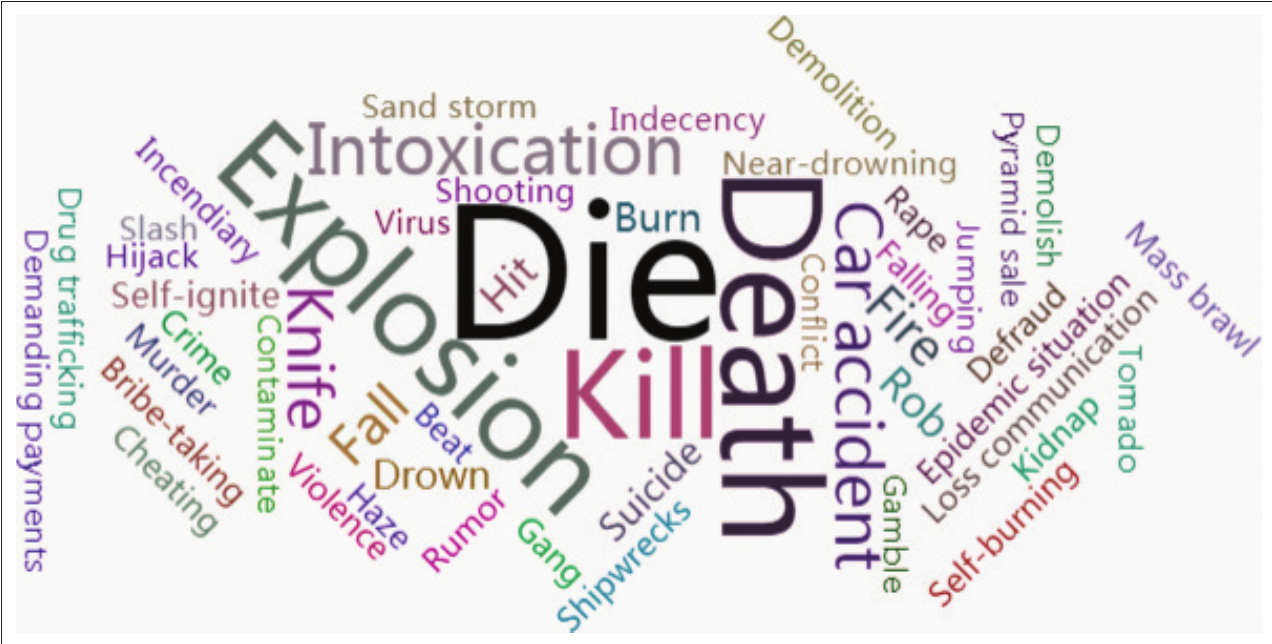
FIGURE 10: Risk elements for public opinion transmission in